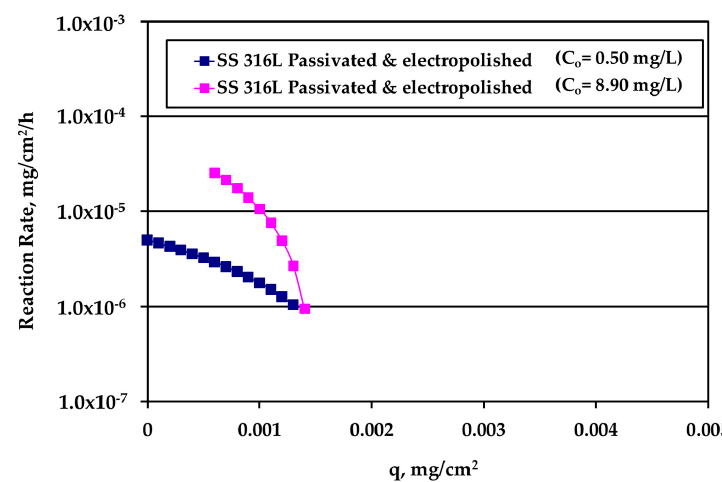
Figure 8. Reaction rate dependence on silver loading for electropolished SS316L solid surface for various silver (bulk) concentration values.